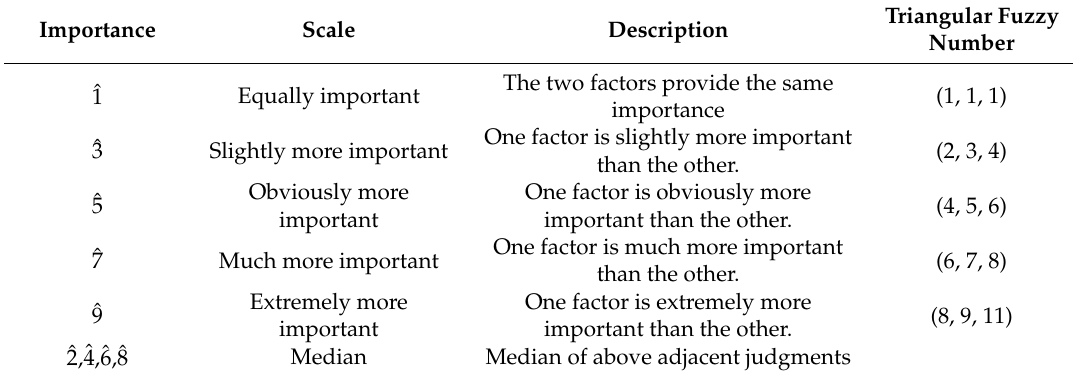
Table 3. Conversion relationship between semantic evaluation and triangular fuzzy number.